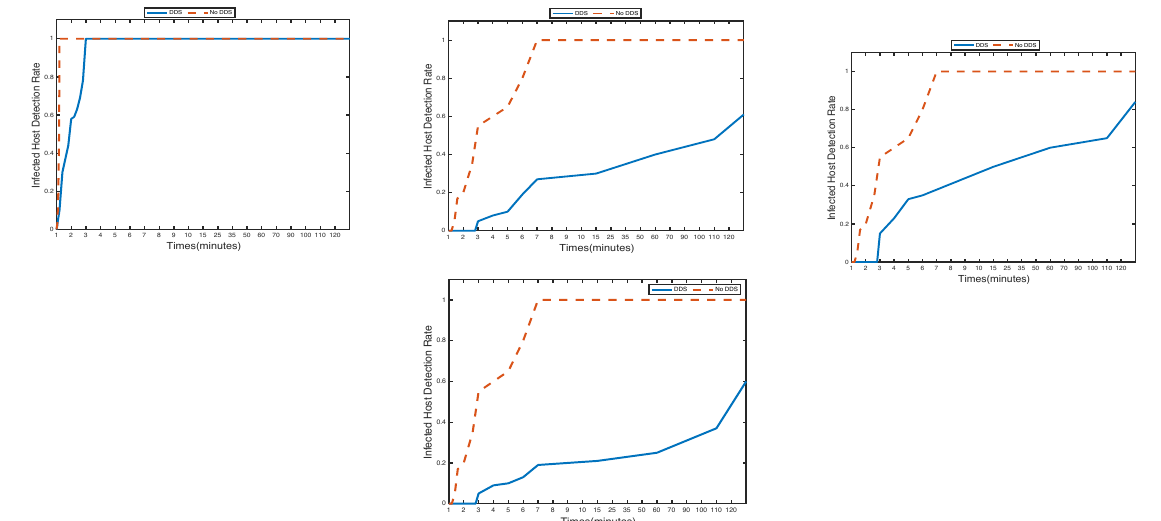
Figure 9. Average vulnerable host detection rate in minutes for the scanning strategies Preference Parallel, Local Preference, Preference Sequential, Non- Preference Sequential with and without our DDS